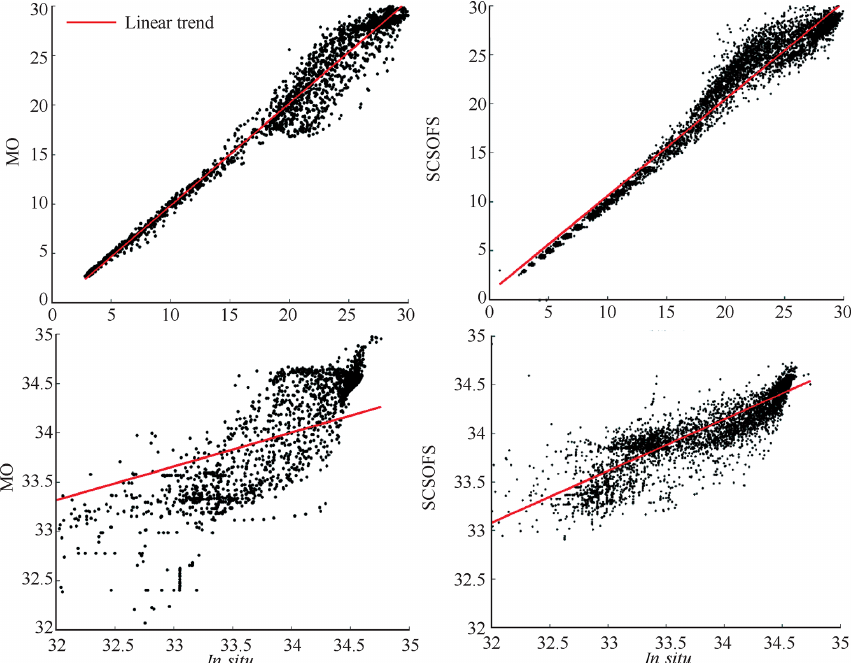
Figure 9. The relative relationships of temperature (upper panels) and salinity (lower panels) between Mercator Océan (left column), SC- SOFS (right column), and the in situ observations of all